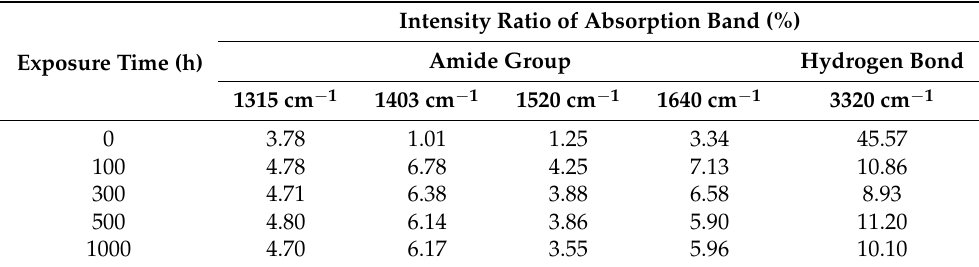
Table 1. Intensity ratio of absorption band before and after ozone